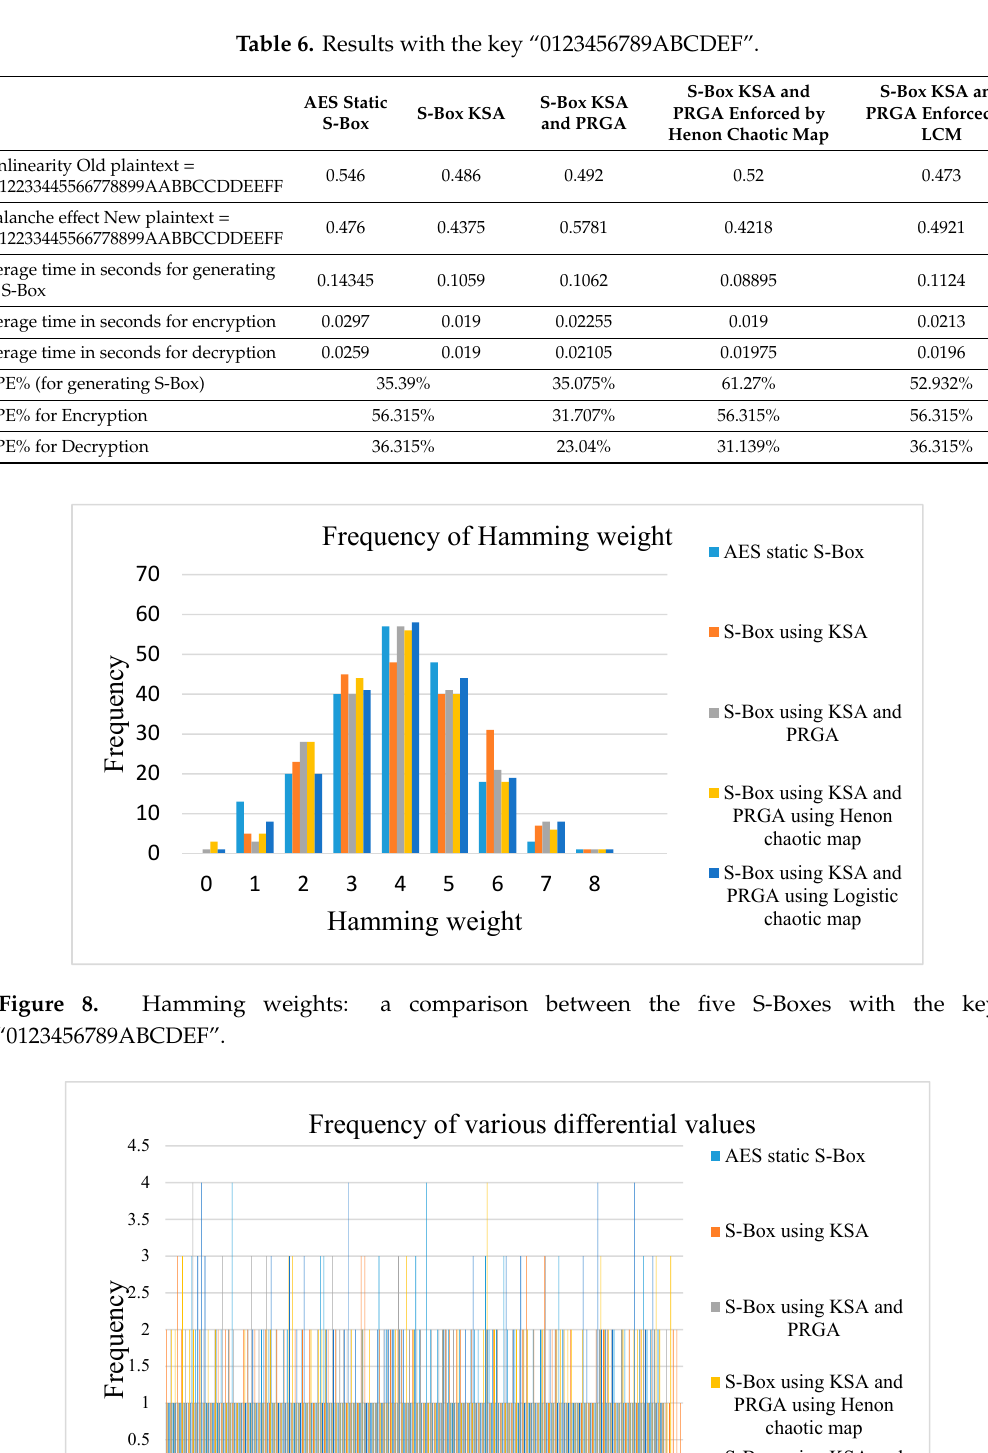
Figure 10. Analysis of Hamming weights according to the bit position for the five S-Boxes using the key “0123456789ABCDEF “. S-Box using KSA and PRGA using Henon chaotic map S-Box using KSA and PRGA using Logistic chaotic map